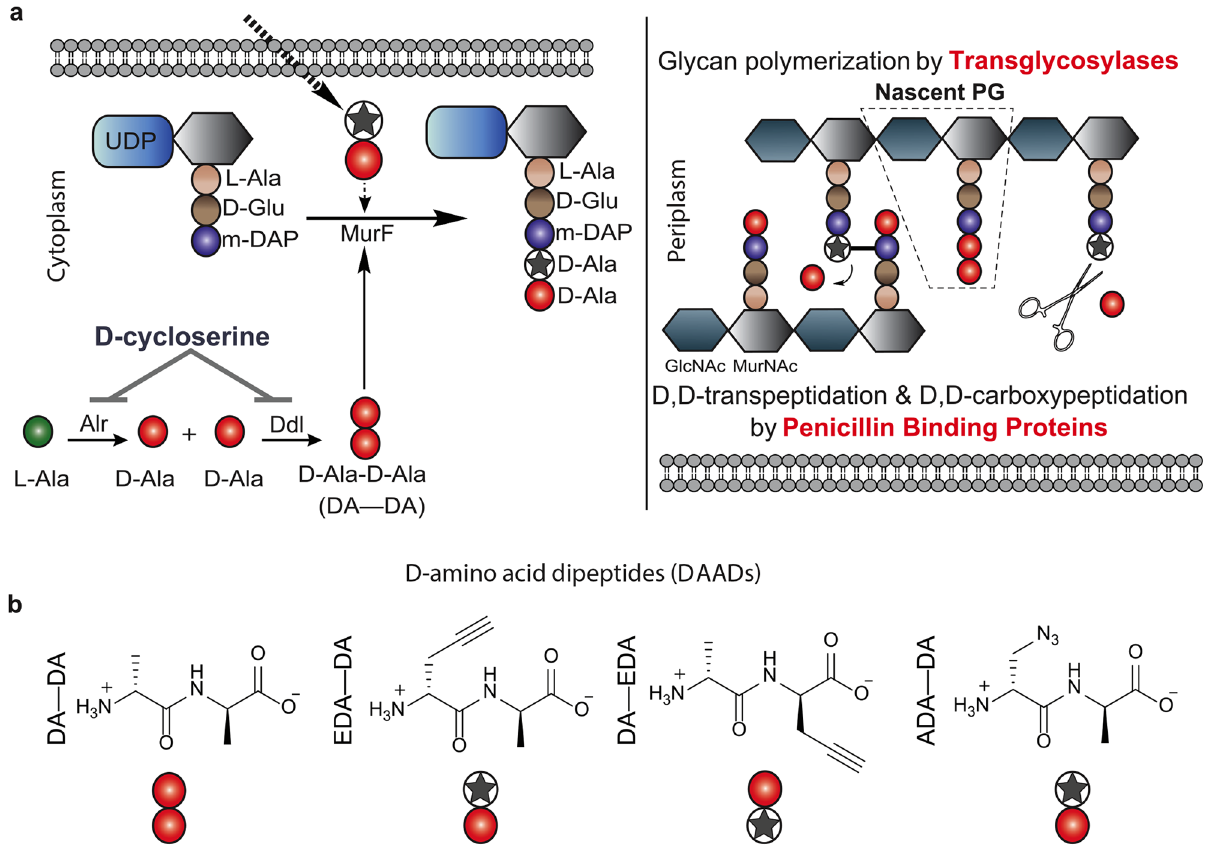
Fig 1. Relevant steps of PG biosynthesis and D-amino acid dipeptide (DAAD) probes used in this study. ( a ) DAADs are taken up by bacteria where they compete with endogenous D-Ala-D-Ala (DA — DA) for incorporation into PG. De novo synthesis of DA — DA is inhibited by D-cyloserine. The pentapeptide PG subunit is then flipped across the inner membrane into the periplasm where it is transglycosylated to form glycan polymers (nascent PG) and crosslinked by penicillin binding proteins (PBPs). Transpeptidation causes cleavage of the terminal D-Ala at position 5. Because the N-terminally labeled portion of DAAD becomes the amino acid at position 4 of the pentapeptide, the label is resistant to this processing and remains on the stem peptide. ( b ) PG- labeling reagents used in this study. Clickable DAADs EDA — DA and ADA — DA. Star represents the clickable amino acid.